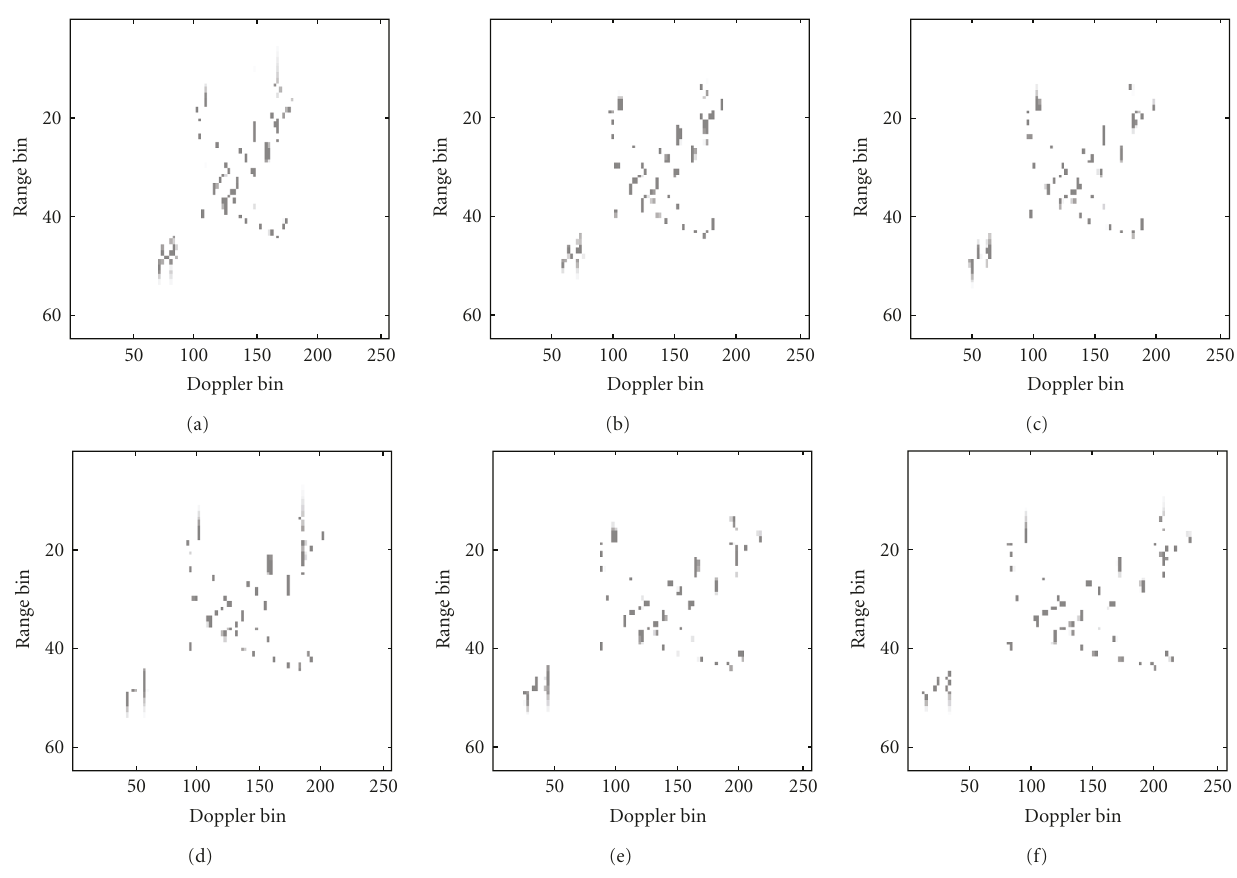
Figure 6: ISAR images of simulated data based on the chirplet decomposition.